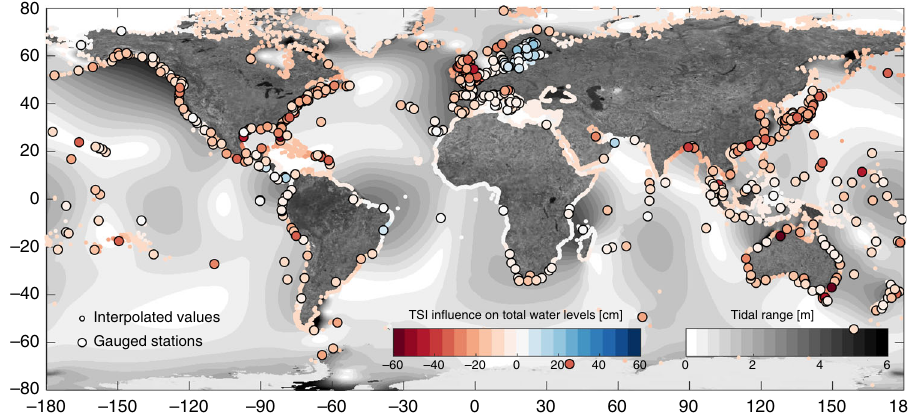
Fig. 5 Global map of interpolated non-linear effects (TSIe) in fl uences on extreme sea levels. The fi gure indicates how changes in non-linear effects (TSIe) extreme sea levels at interpolated (small dots) and observational (bold dots) stations which have been derived using the regression model of Eq. (1). Sites with negative (i.e., reduced extreme sea levels shown red) and positive (i.e., increased extreme sea levels shown blue) non-linear effects are separated according to the colour